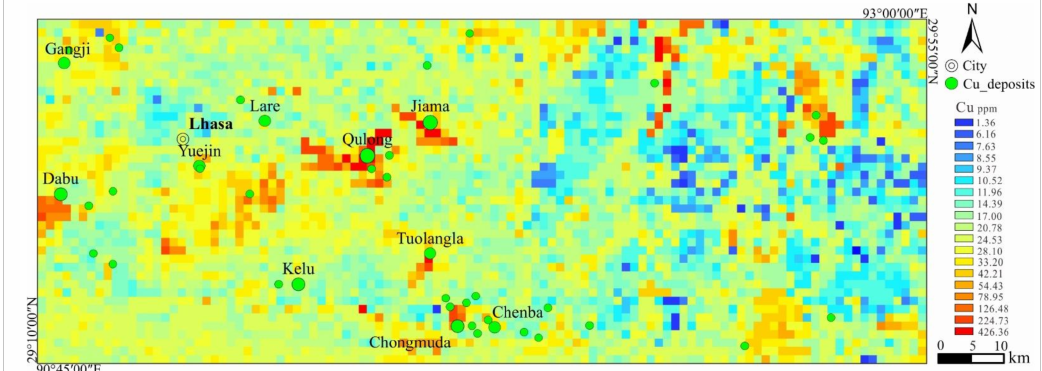
Figure 4. Raster map of Cu: the study area is divided into 108 × 41 grids with a grid size of 2 km × 2 km.